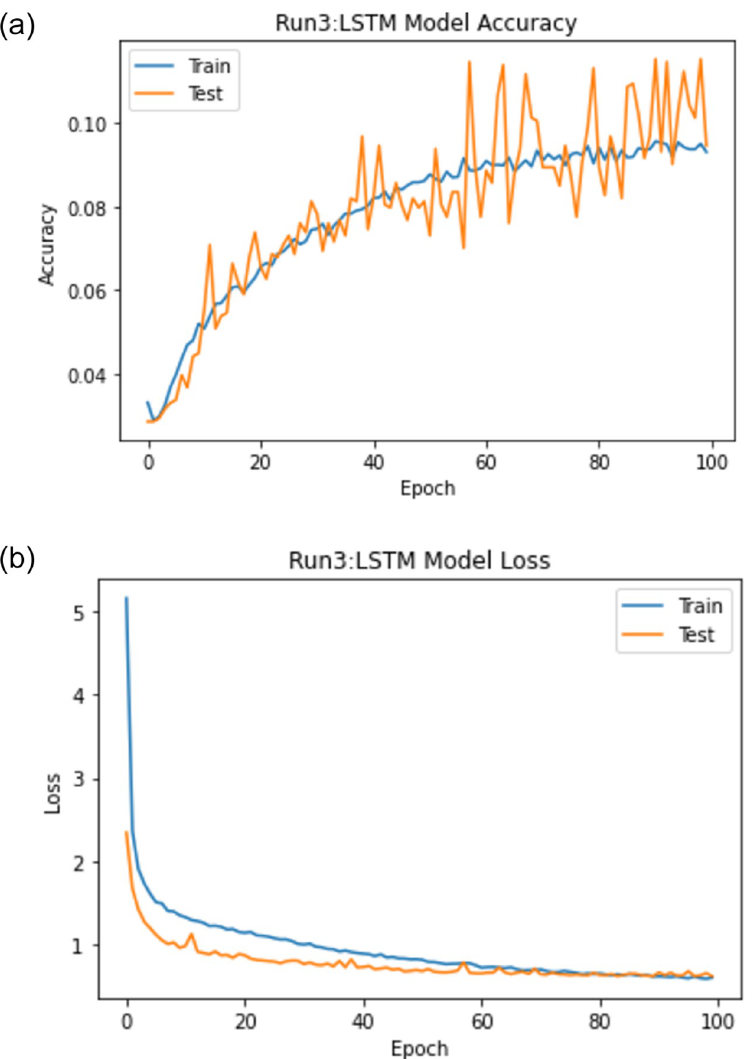
Fig 16. The LSTM-GWO accuracy and loss with experiment